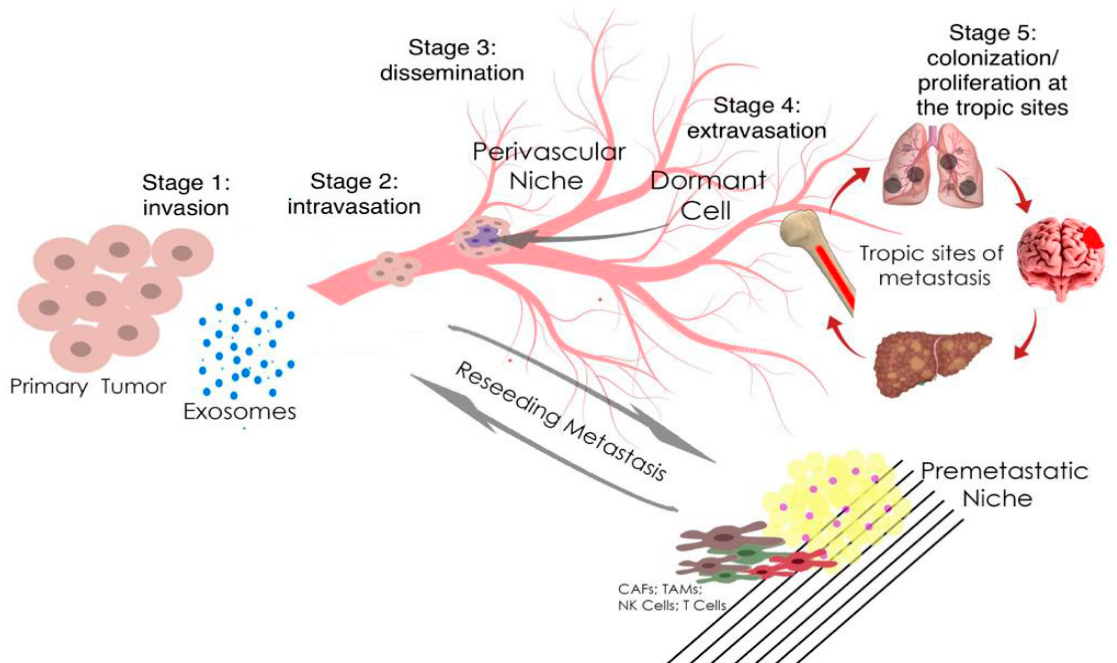
Figure 1. Metastasis and tumor invasion. Tumor cells at the primary tumor sites leave their primary site by dint of invasion into the surrounding stroma (stage 1: invasion). Then they penetrate (stage 2: intravasation) and migrate through the blood or lymph vessels into the circulation (stage 3: dis ‐ semination). Some of tumor cells survive and migrate to the target organ parenchyma (tropic sites of metastasis), which is the “pre ‐ metastatic niche” (stage 4: extravasation). Finally, cells adapt and proliferate to form metastasis with the subsequent formation of a clinically obvious tumor (stage 5: colonization/proliferation at the tropic sites). Myeloid cells, such as tumor ‐ associated macrophages (TAMs), can promote metastatic spread through blood and lymphatic vessels. Transforming growth factor ‐β (TGF ‐β ), produced by TAMs, and cancer ‐ associated fibroblasts (CAFs) are regulators of the epithelial–mesenchymal transition and metastasis. In the pre ‐ metastatic niche, natural killer cells (NK cells) and T cells inhibit tumor growth.